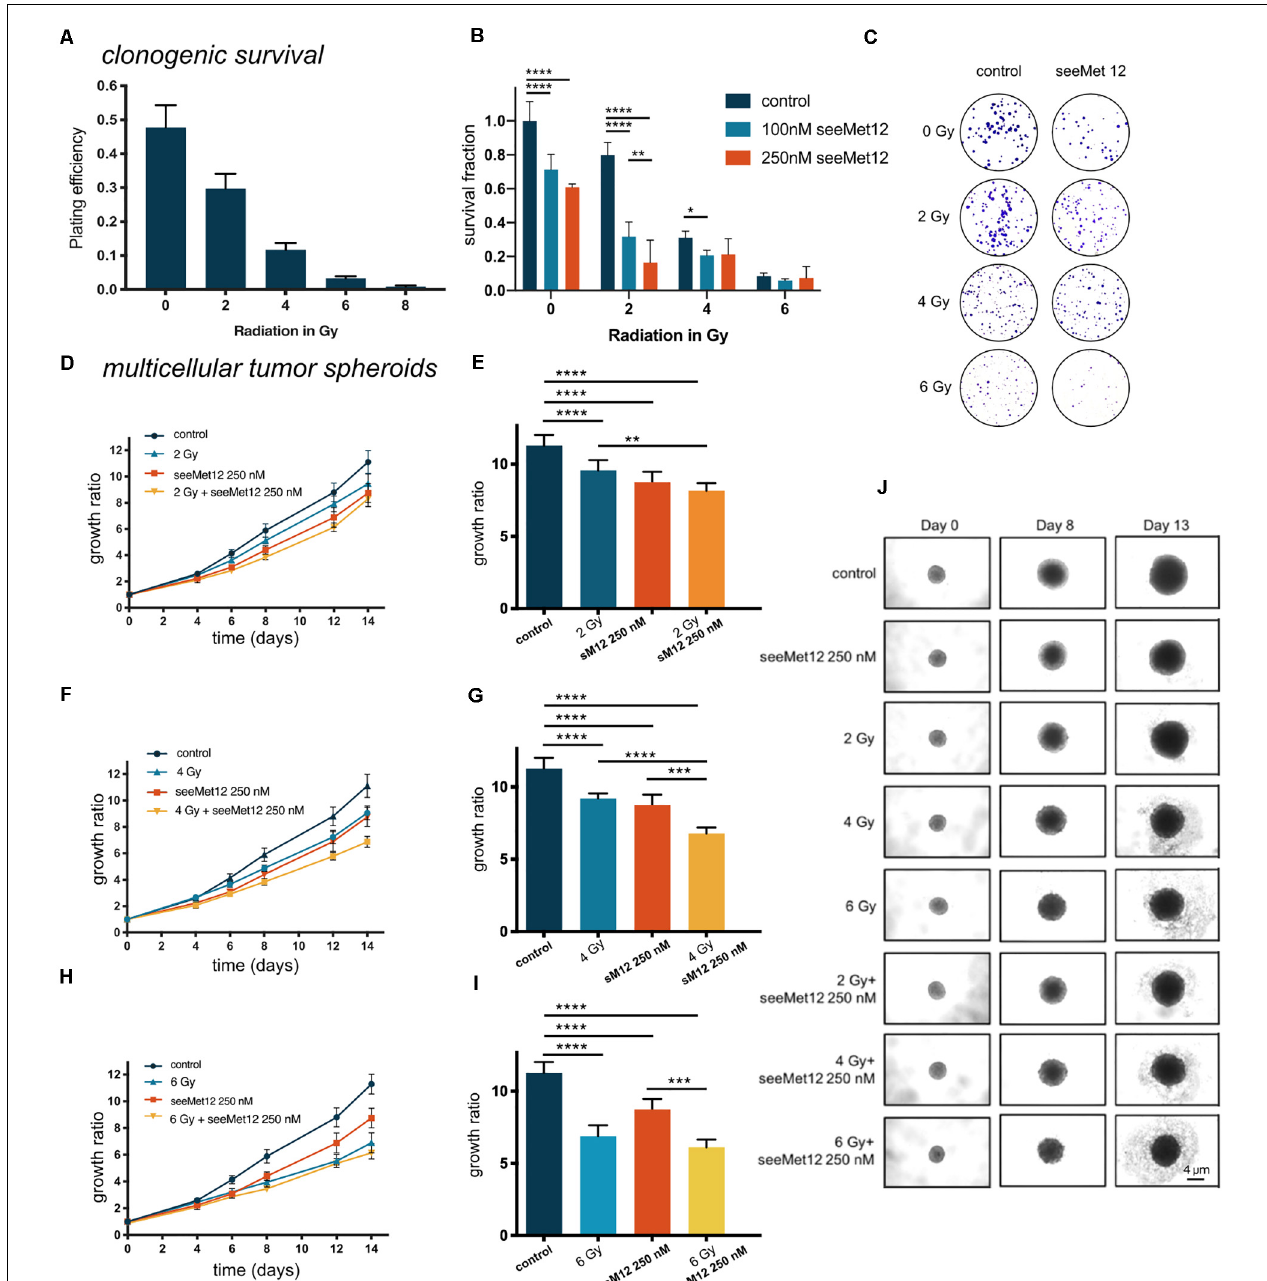
FIGURE 4 | Characterization of seeMet 12 therapy in combination with external radiotherapy. (A) Cell viability (clonogenic survival) of HT-29 cells after exposure to radiotherapy of 2, 4, 6, or 8 Gy. N = 4 error bars represent SD. (B) Clonogenic survival assay of HT-29 cells. Cells were exposed to 100 or 250 nM seeMet 12 and/or radiotherapy of 2, 4, and 6 Gy, N = 4, error bars represent SD. (C) Representative pictures of the colonies in the clonogenic survival assay after 14 days for control, monotherapy of seeMet 12 and 0, 2, 4, and 6 Gy radiation and the combination of both treatments. (D,F,H) Multicellular HT-29 tumor spheroid assays with 100 or 250 nM seeMet 12 and/or radiotherapy of 2, 4, or 6 Gy. n = 10 for control and radiotherapy alone, n = 5 for treatment groups, Error bars represent SD. (E,G,I) Comparison of the spheroid sizes in panels (D,F,H) on day 14. Error bars represent SD. (J) Representative images of the spheroids after the different treatments. Size reference bar = 4 µ m. Considered to be statistically significant * p < 0.05, ** p < 0.01, *** p < 0.001, **** p <